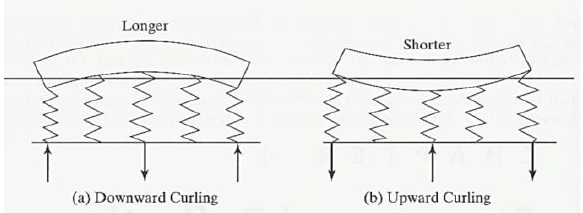
Figure 1: Curling condition in rigid pavement: (a) Negative temper- ature gradient, the temperature at the top < temperature at the bottom; and (b) positive temperature gradient, the temperature at the Top > temperature at the bottom